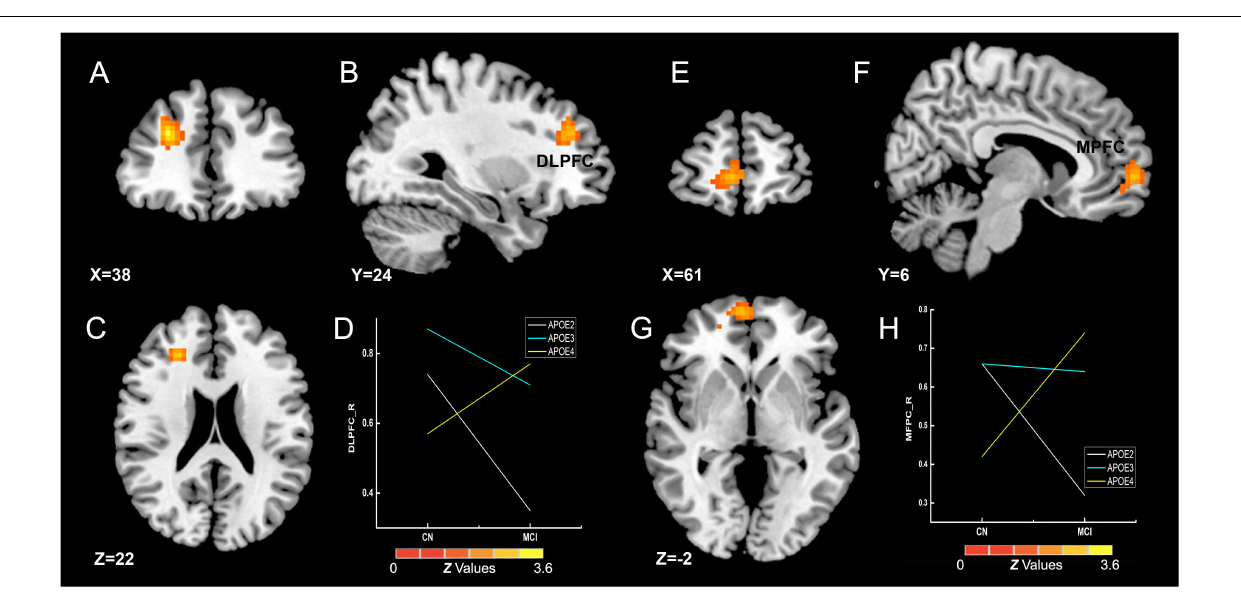
FIGURE 4 | Interactive influence of diagnosis and APOE genotype on gFCD ( p < 0.005; α < 0.001; 3dClustSim corrected). (A–C,E–G) Interactive influence of diagnosis and APOE genotype on the brain functions in the right DLPFC and MPFC. (D,H) The diagrams illustrate the interactive influence of diagnosis and APOE genotype in the DLPFC and MPFC. Compared to the CN group, the gFCD values in the DLPFC and MPFC was higher in patients with MCI who had the APOE ε 2+ genotype and was lower in those who had the APOE ε 4+ genotype; no significant alteration was noted in the MCI group with the APOE ε 3 ε 3 genotype. gFCD, global functional connectivity density; CN, cognitively normal; MCI, mild cognitive impairment; DLPFC, dorsolateral prefrontal cortex; MPFC, medial prefrontal